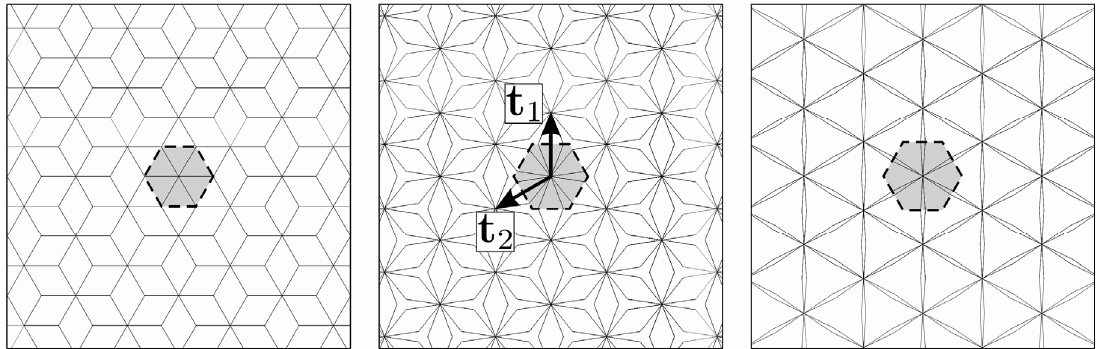
Figure 3: Periodic microstructure. Three different configurations, for different values of α are shown. The grey dashed region is the unit cell of the Bravais lattice where t 1 and t 2 are the primitive